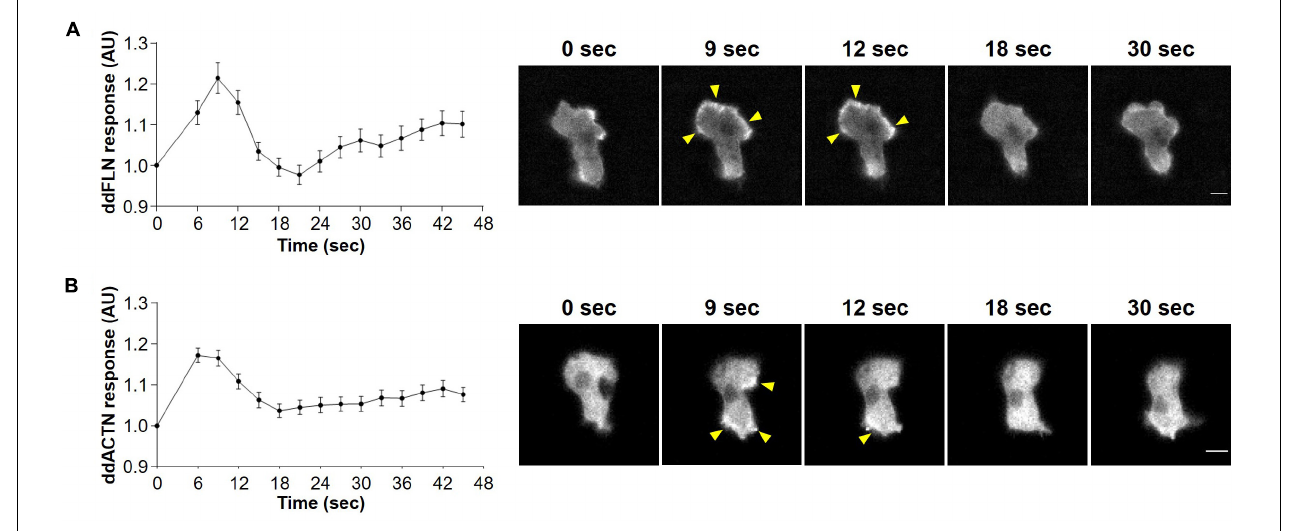
FIGURE 1 | Localization of filamin and α -actinin in response to acute treatment with shear flow. Wild-type cells expressing mCherry-tagged ddFLN (A) or mCherry-tagged ddACTN (B) were imaged every 3 s by epifluorescence microscopy with an RFP filter set under 630X magnification with oil immersion. Shear flow at 45 dyn/cm 2 was applied at time 0 for 2 s. Response was measured as protein relocalization from the cytosol to the cell cortex. Data is displayed as mean ± SE of 45 (A) or 85 (B) cells pooled from three independent experiments. A representative cell is shown to the right of the graph. Arrowheads point to mCherry-tagged protein accumulation at the cortex. Scale bar, 5 µ